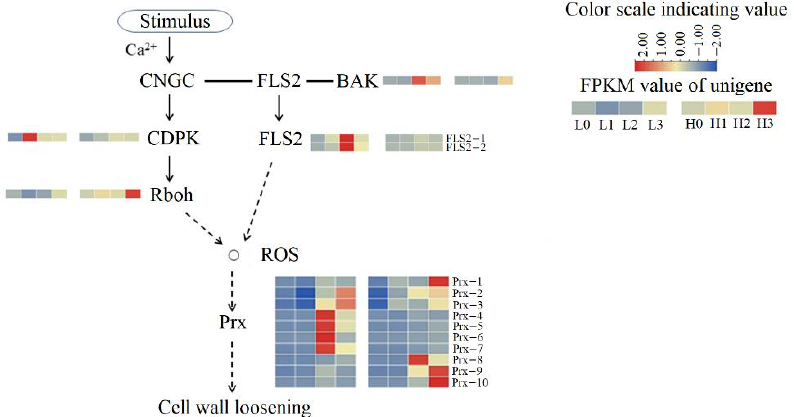
Figure 7. Cell wall loosening process. FPKM value of unigenes of the enzymes are indicated from blue to red (low to high) across the stage 0, stage 1, stage 2, and stage 3 under low R/FR ratio (L0, L1, L2, and L3) and high R/FR ratio (H0, H1, H2 and H3). CNGC: cyclic nucleotide gated channel; FLS2: Flagellin sensitive2; BAK: brassinosteroid-associated kinase; CDPK: calcium-dependent protein kinase; Rboh: respiratory burst oxidase homologs; “ о ” indicates reactive oxygen species (ROS) resulting from the enrichment of peroxidase (Prx). Dotted lines indicate that there are more than two reaction steps in the biological process.